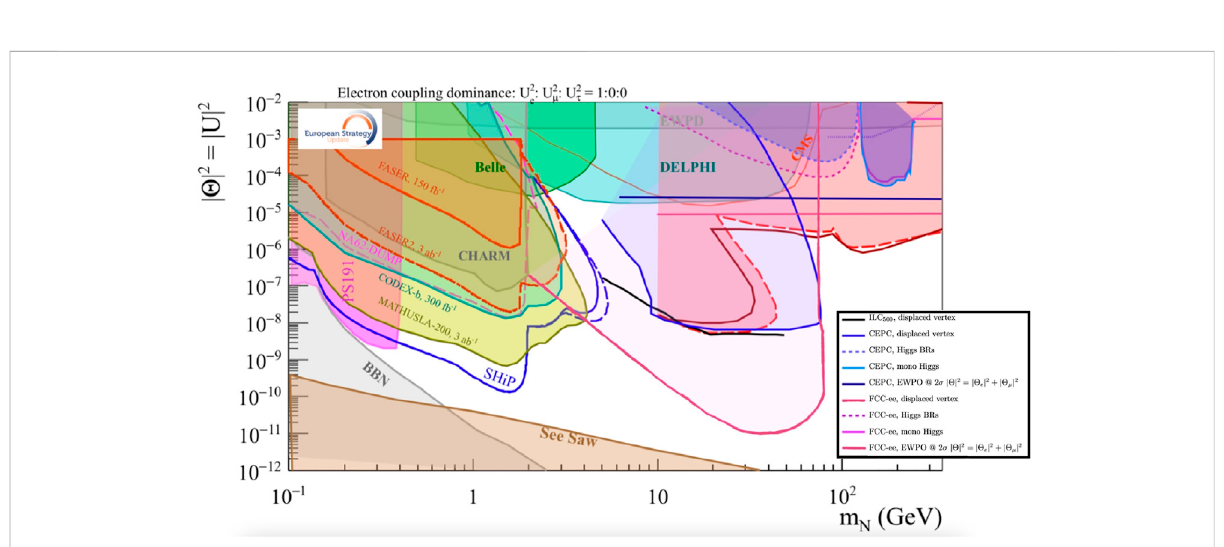
FIGURE 2 90% CLexclusion limitsfor aHeavy NeutralLepton mixed with theelectron neutrino,as presented intheEuropean Strategy for Particle Physics Brie fi ngBook[80].TheFCC-eecurvesarein(overlined)darkpurple — forFCC-ee,thisisequivalenttoaplotasfunctionofthesumofmatrixelements squared |U N | 2 . The curve below the Z boson mass corresponds to the combined LLP and prompt analysis performed with 10 12 Z in Ref. [79]. The horizontallimitathighmassesresultsfrom theeffect oflight-heavy neutrino mixingon theEW precision observables andremainsvalid upto O (1000